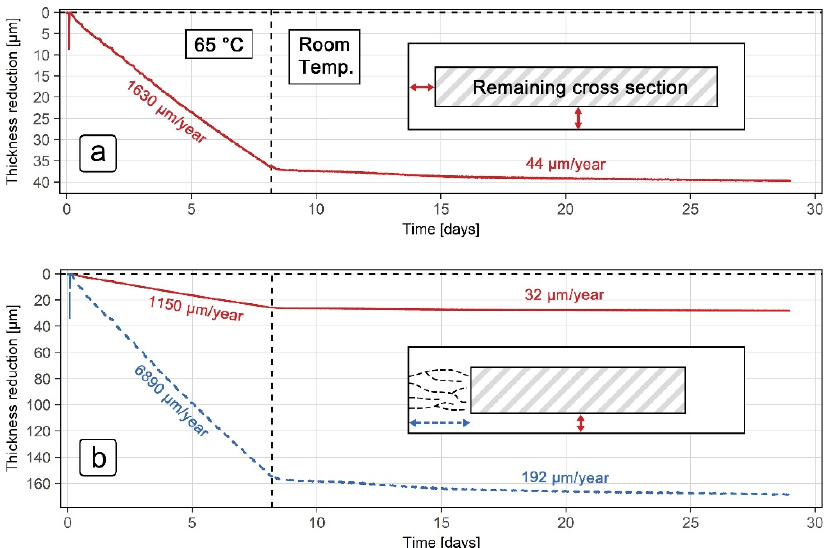
Figure 8. ER thickness reduction results for grade 316L steel in the 10% H 2 SO 4 solution with 5000 mg/L NaCl: ( a ) model using the same cross-section reduction in vertical and horizontal direction; ( b ) model using the maximum reduction in cross-section in the horizontal direction.